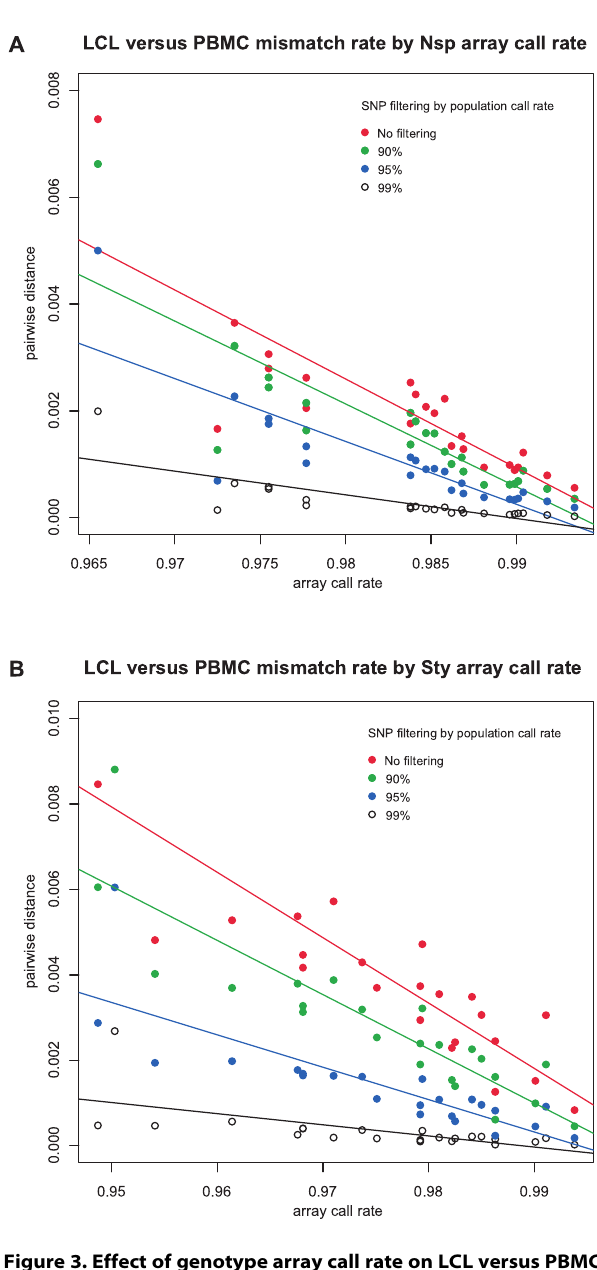
Figure 3. Effect of genotype array call rate on LCL versus PBMC genotypic fidelity. Relationship between genotypic fidelity of LCL and PBMC pairs (mismatch rate, estimated using pairwise distance) and the array call rate. For each LCL versus PBMC genotypic pair, we compared the LCL versus PBMC mismatch rate to the lesser of the two array call rates. Mismatch rates are estimated at different levels of SNP filtering by population call rate: no filtering, 90%, 95%, and 99% percent population call (Table 3; Nsp array: slope = 2 0.167, r 2 = 0.70, P =6.42 6 10 2 7 ), and is alleviated with increasingly stringent filtering by population call rate, as seen at the 99% population call rate (Table 3; Nsp